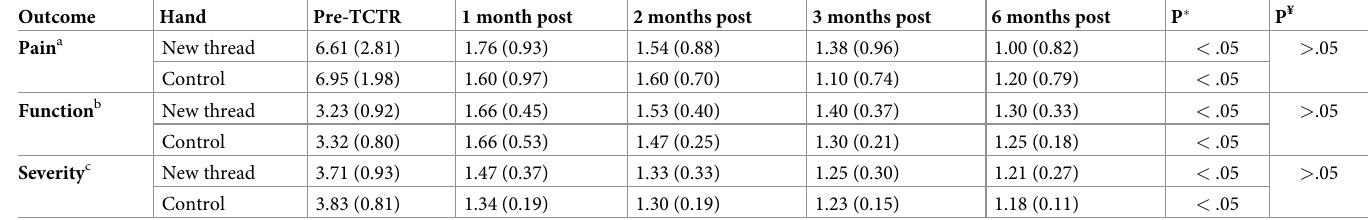
Table 4. Long term recovery following TCTR: Mean